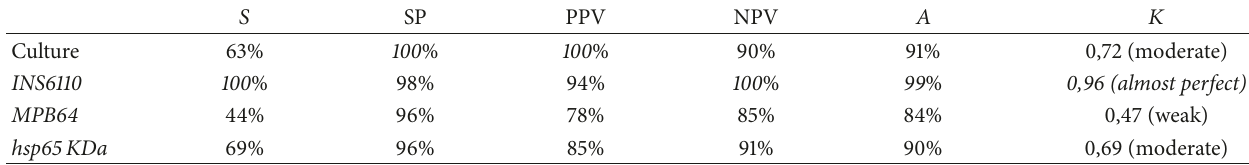
Table 5: Culture and real time PCR results for 100 samples included on the study.